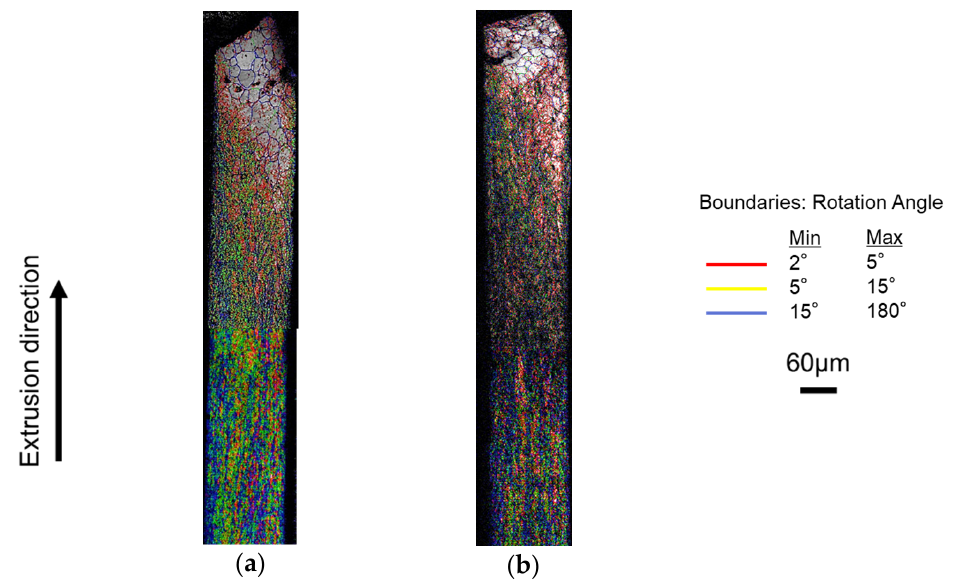
Figure 7. IPF map of the extrusion by EBSD: ( a ) mirror surface punch; and ( b ) grooved punch (depth 5 µm).